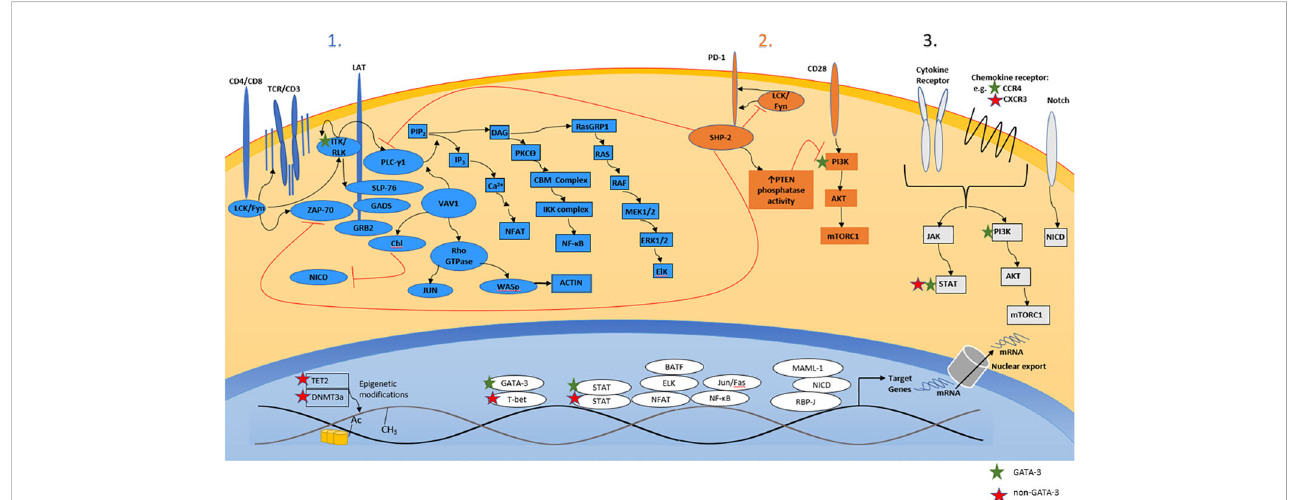
FIGURE 2 A three-signal model of T-cell lymphomagenesis. Ligands and cytokines/chemokines provided by constituents of the tumor microenvironment engage three broad classes of cell-surface receptors expressed by malignant T cells, including the T-cell receptor ( “ signal 1 ” ), costimulatory/coinhibitory receptors ( “ signal 2 ” ), and cytokine/chemokine receptors ( “ signal 3 ” ). Receptor engagement instigates a signaling barrage culminating in signi fi cant transcriptional changes that regulate the proliferation, survival, cytoskeletal remodeling, and metabolism of malignant T cells. Relevant primary/secondary messengers and transcription factors are shown, and those that are preferentially expressed (or activated) in GATA-3 or non-GATA-3 PTCL are